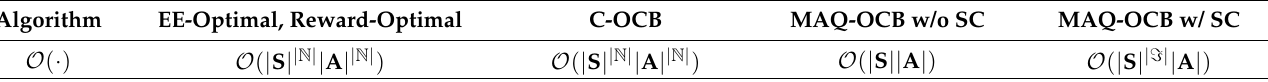
Table 2. Computational complexity analysis.